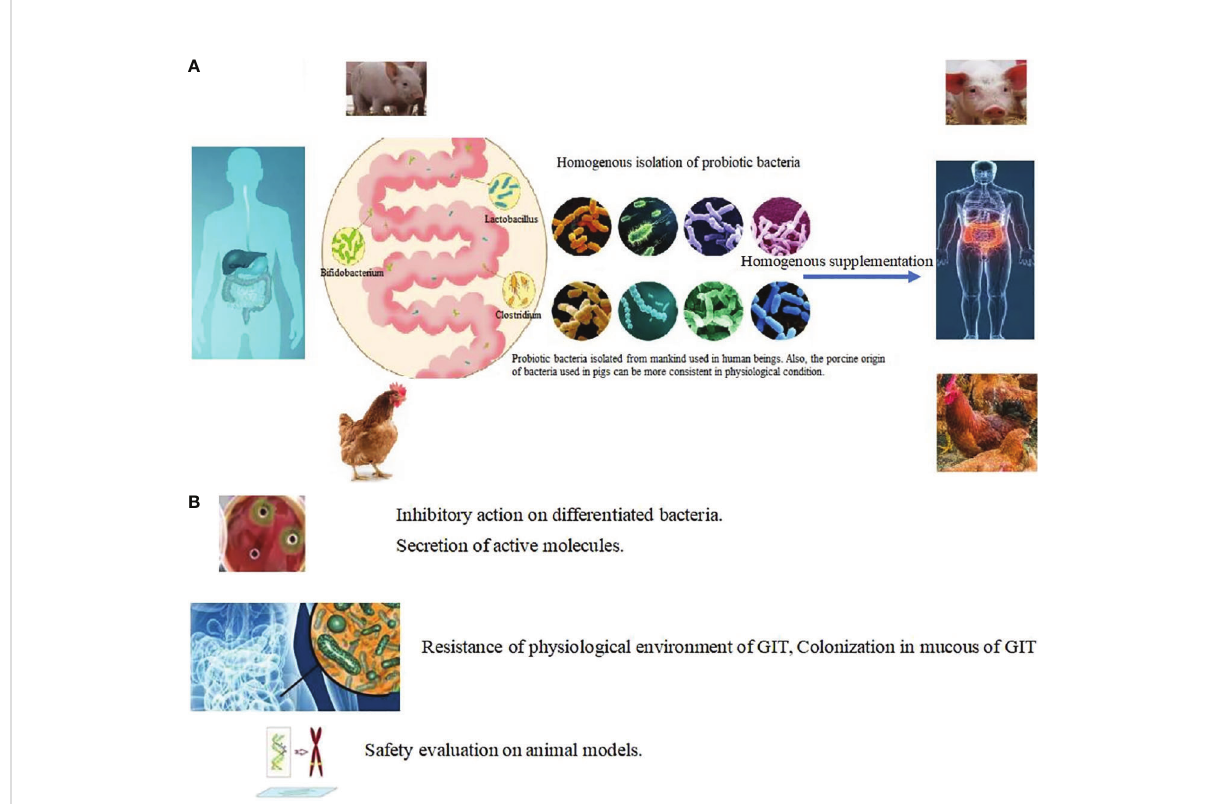
FIGURE 5 Targeted isolation in choosing probiotic bacteria. (A) Homogeneous isolation: Probiotic bacteria isolated from mankind used in human beings. Also, the porcine origin of bacteria used in pigs can be more consistent in physiological condition. Lactobacillus, Akkermansia , Bacillus , Bi fi dobacterium , Lactococcus , Streptococcus , Clostridium and Prevotellacea were harvested from organs and supplemented homogenously in same animals. (B) Targeted methods in choosing probiotic